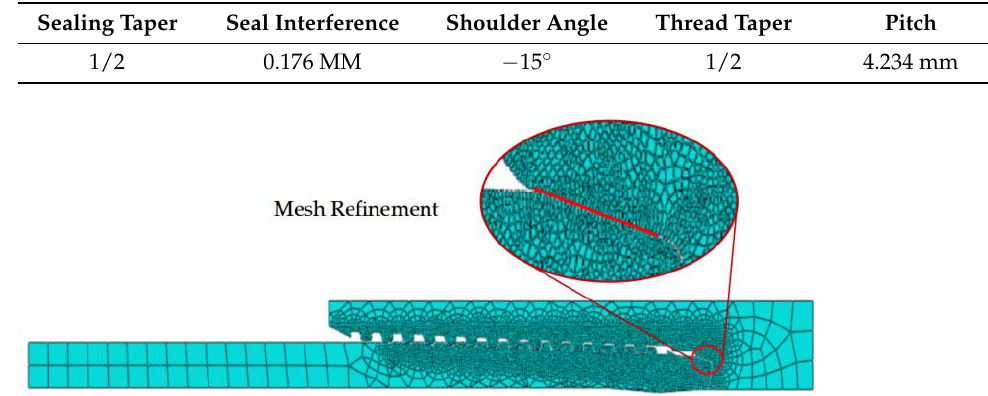
Figure 7. Finite element model of premium connection.